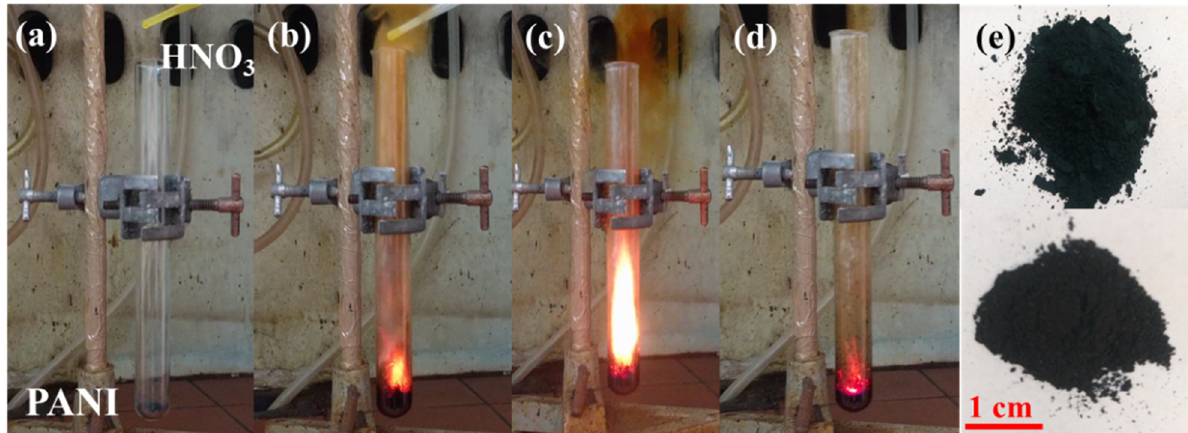
Figure 11. ( a ) The test tube containing polyaniline before nitric acid addition. ( b – d ) Dropwise addition of the acid sparked ignition, emitting an intense burst of flame. ( e – top ) The starting material used for the reaction; the dark green hue of polyaniline is indicative of its conductive state. ( e – bottom ) The residue within the tube was collected and washed extensively to afford a fine dark-brown powder.